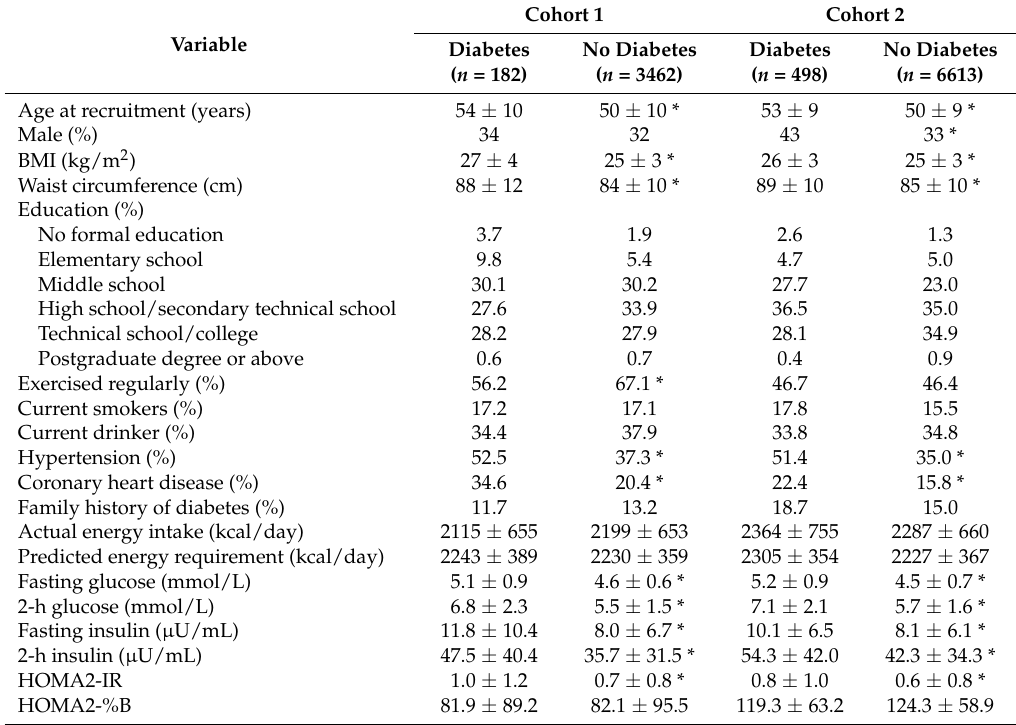
Table 1. Selected baseline characteristics of the Harbin People’s Health Study (Cohort 1, 2008–2012) and the Harbin Cohort Study on Diet, Nutrition and Chronic Non-Communicable Diseases (Cohort 2,